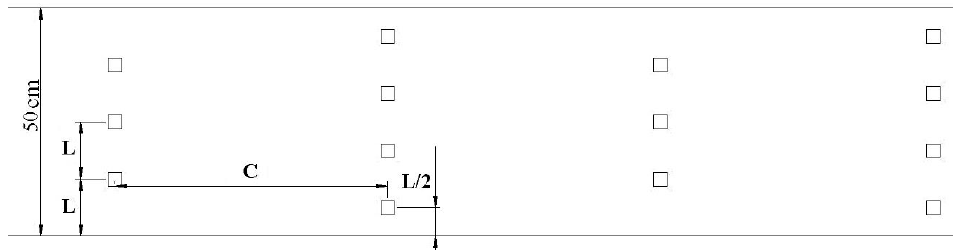
Figure 1. Sketch of the experimental devices.